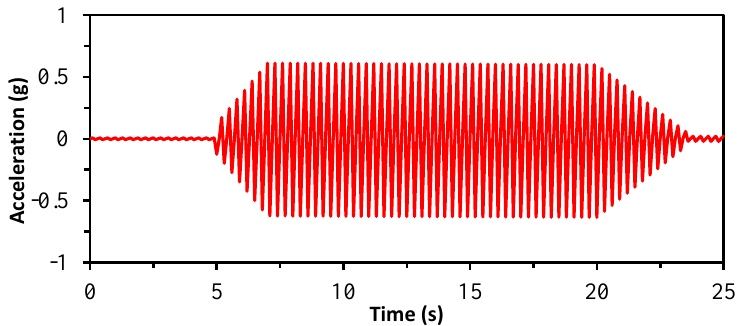
Figure 17. Input horizontal seismic acceleration.